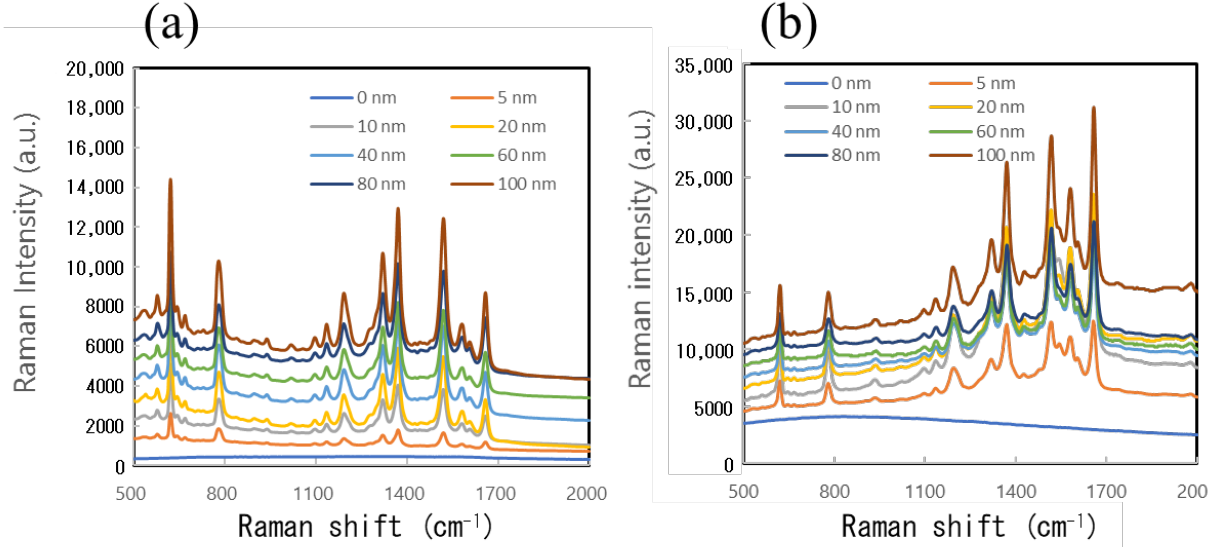
Figure A3. Dependence of SERS spectra of 1 mM R6G on the silver deposition thickness, 0, 5, 10, 20, 40, 60, 80 and 100 nm, for ( a ) a 633 nm irradiation and ( b ) a 532 nm irradiation for chestnut scales from S. charonda . Here, the baselines are staggered vertically to prevent overlapping of spectra.